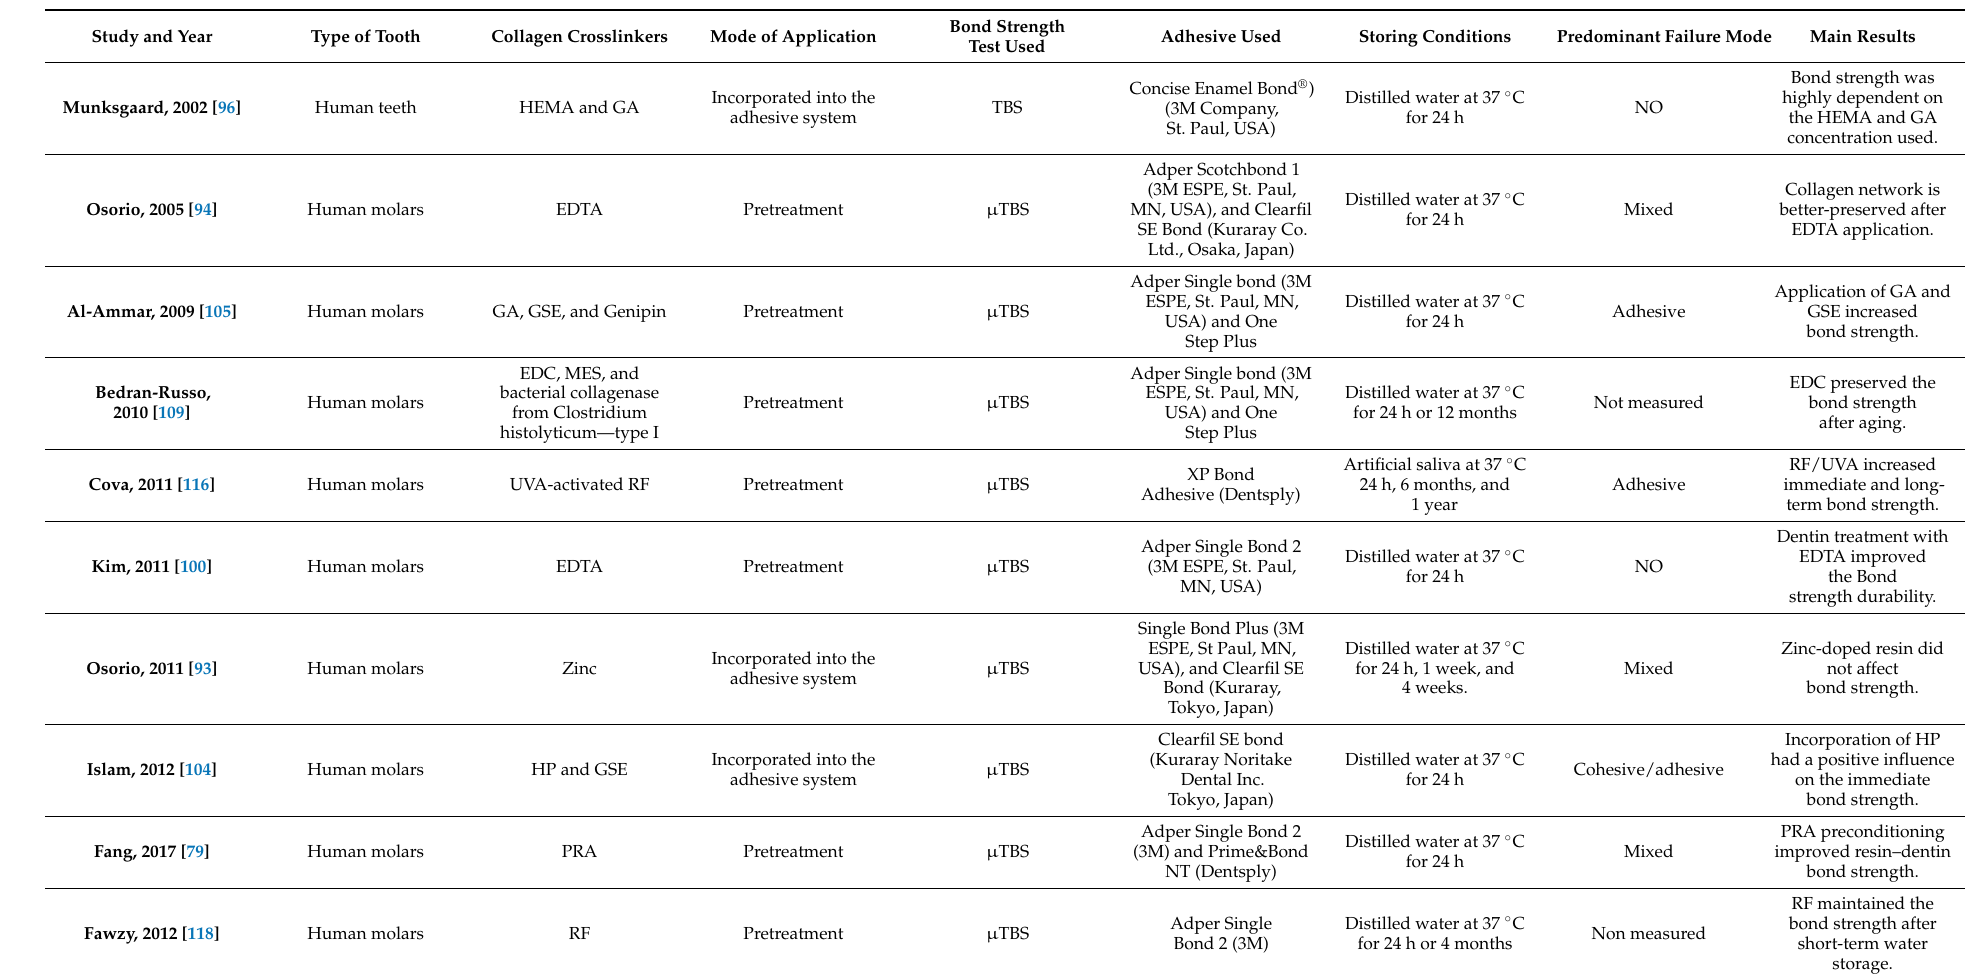
Table 3. Characteristics of the studies included in the